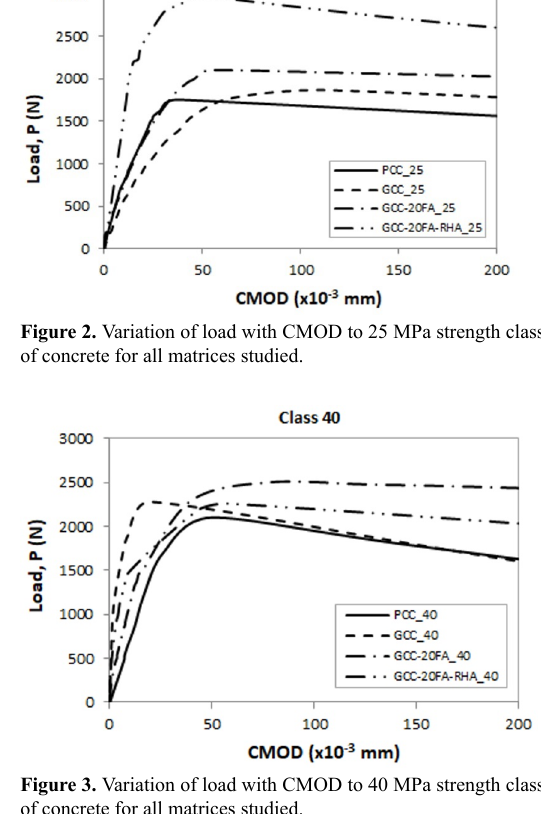
Figure 3. Variation of load with CMOD to 40 MPa strength class of concrete for all matrices studied.